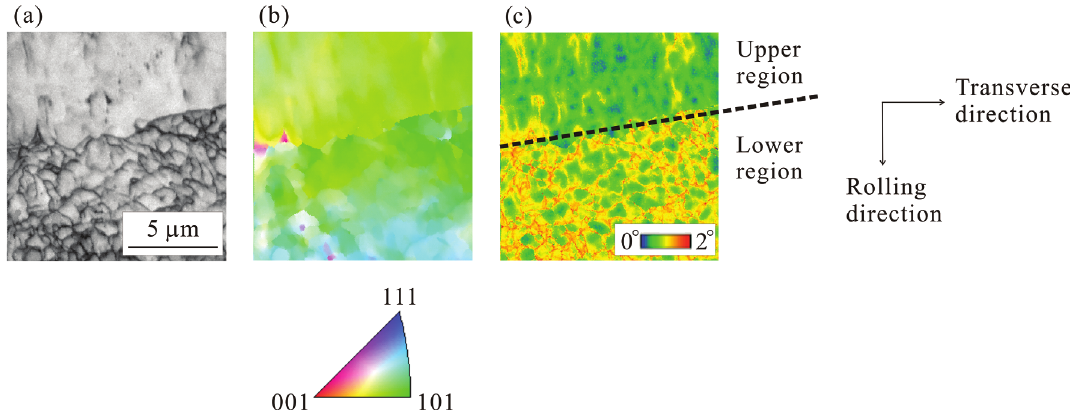
Figure 4: Magnification of a {110} grain of pure copper cold rolled at 50% reduction: (a) image quality map, (b) ND-IPF map, (c) KAM